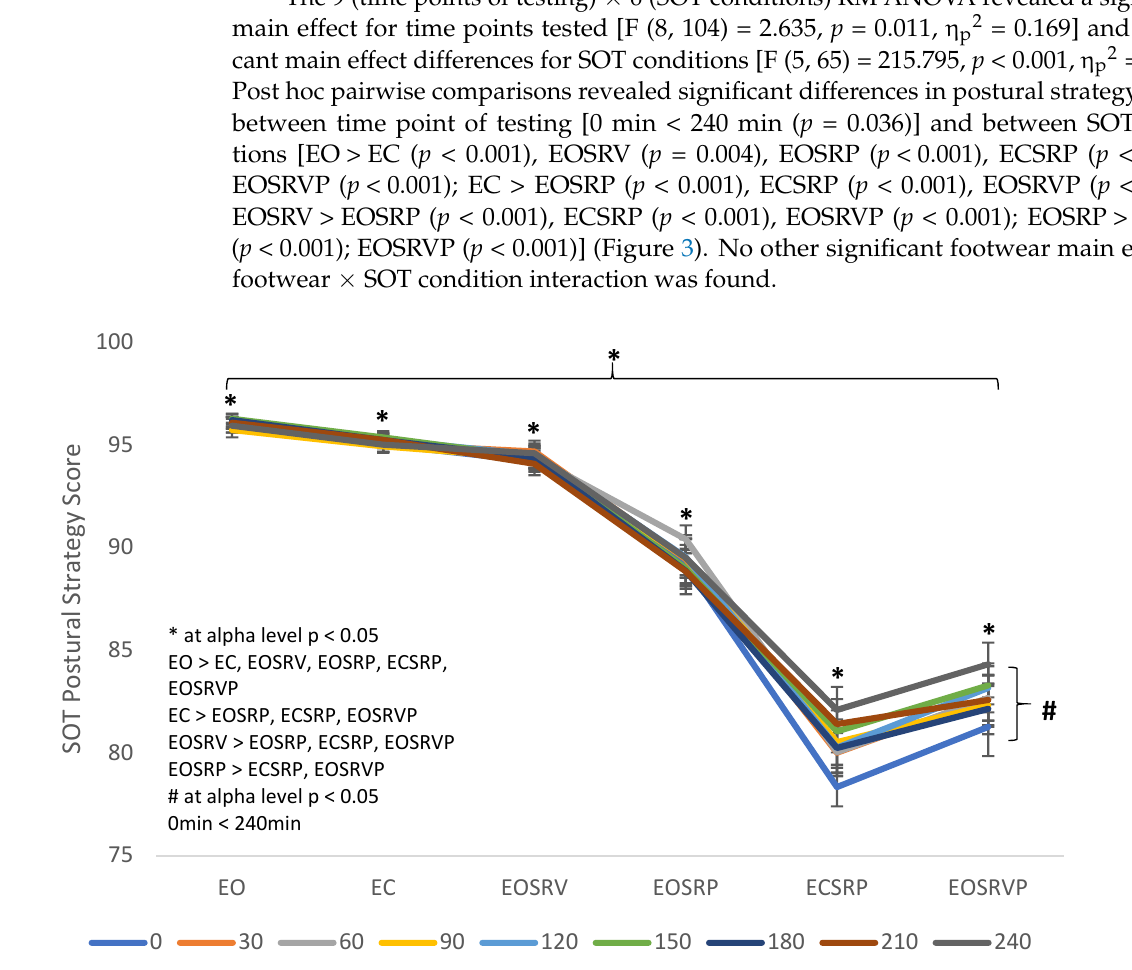
Figure 3. Sensory organization test (SOT) postural strategy scores for nine time points of testing: 0 min, 30 min, 60 min, 90 min, 120 min, 150 min, 180 min, 210 min, and 240 min, during the six SOT conditions: eyes open (EO), eyes closed (EC), eyes open sway referenced vision (EOSRV), eyes open sway referenced platform (EOSRP), eyes closed sway referenced platform (ECSRP) and eyes open sway referenced vision and platform (EOSRVP). * indicates significant difference for SOT conditions. # indicates significant difference between time points of testing. List within the graph explains the significant pairwise comparisons. Significant differences at p < 0.05 level; bars represent standard errors.